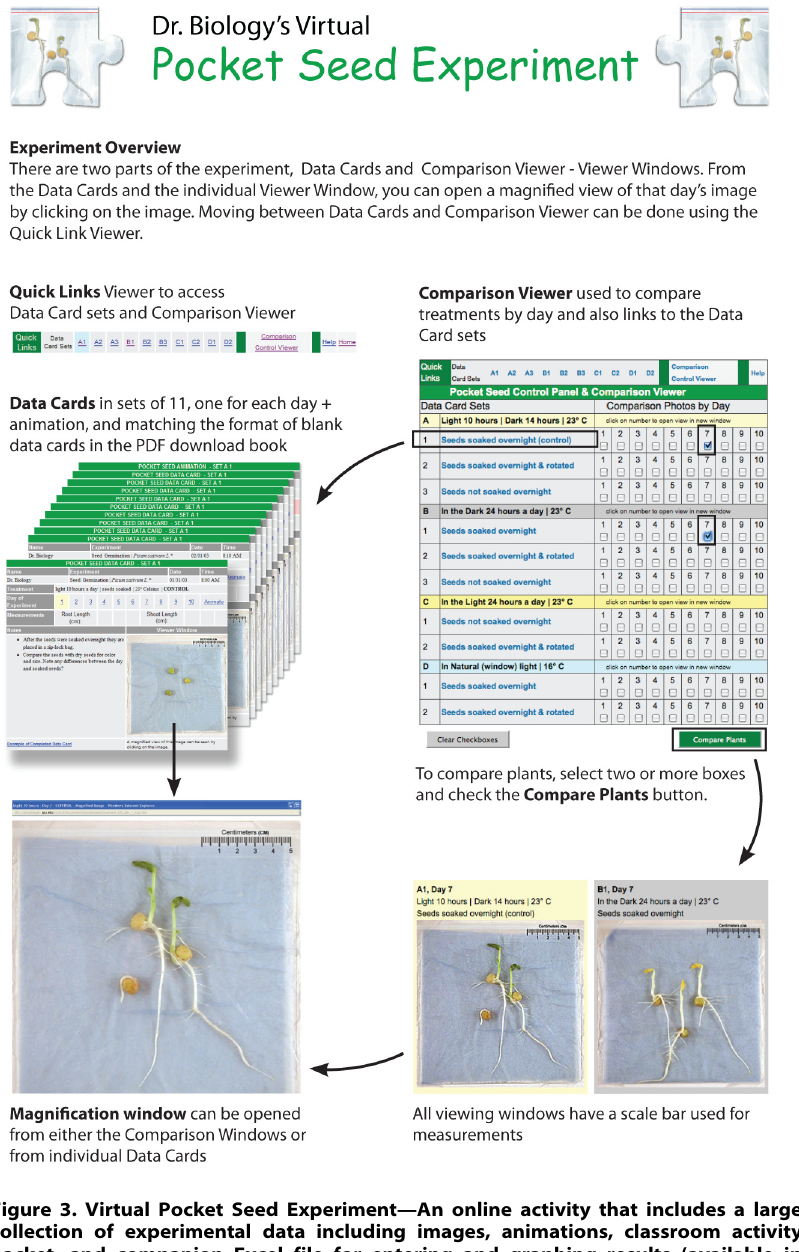
Figure 3. Virtual Pocket Seed Experiment—An online activity that includes a large collection of experimental data including images, animations, classroom activity packet, and companion Excel file for entering and graphing results (available in English, Spanish and